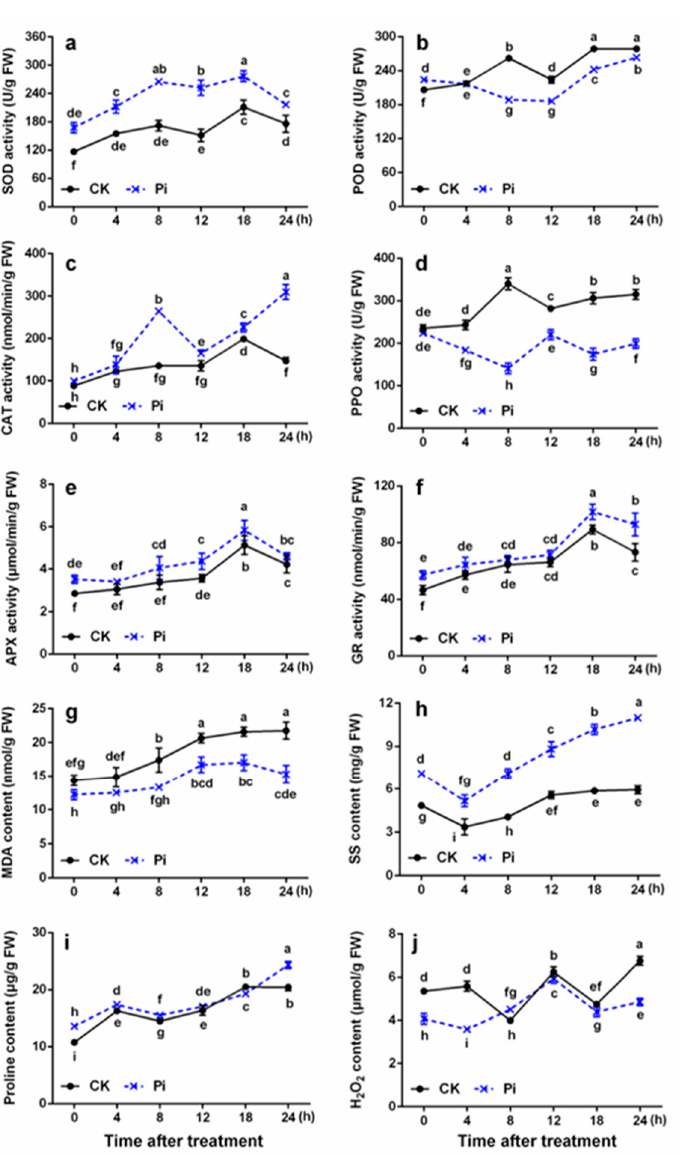
Figure 4. The cold-related physiological and biochemical indexes in banana leaves inoculated or non-inoculated with P . indica under cold stress. ( a ) Superoxide dismutase activity; ( b ) peroxidase activity; ( c ) catalase activity; ( d ) polyphenol oxidase activity; ( e ) ascorbate peroxidase activity; ( f ) glutathione reductase activity; ( g ) malondialdehyde content; ( h ) soluble sugar content; ( i ) proline content; and ( j ) hydrogen peroxide content. FW, fresh weight; CK, control, plants non-inoculated with P. indica ; Pi, plants inoculated with P . indica . Different letters above the bars indicate a significant difference ( p < 0.05) from CK (0 h) between CK and Pi groups. Error bars represent SDs ( n = 3).